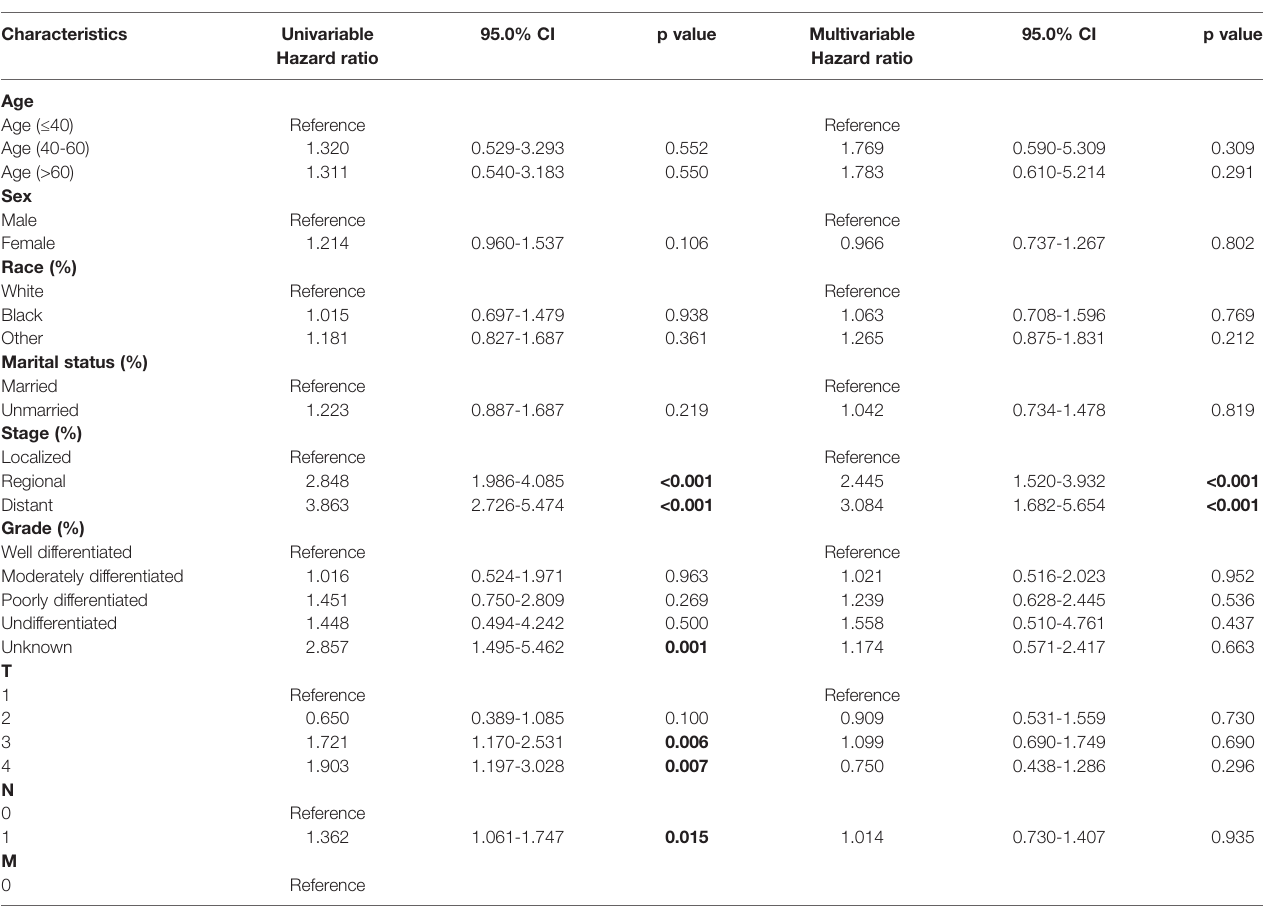
TABLE 3 | Univariate and multivariate analyses of the 1:2 matched cohort (OS).